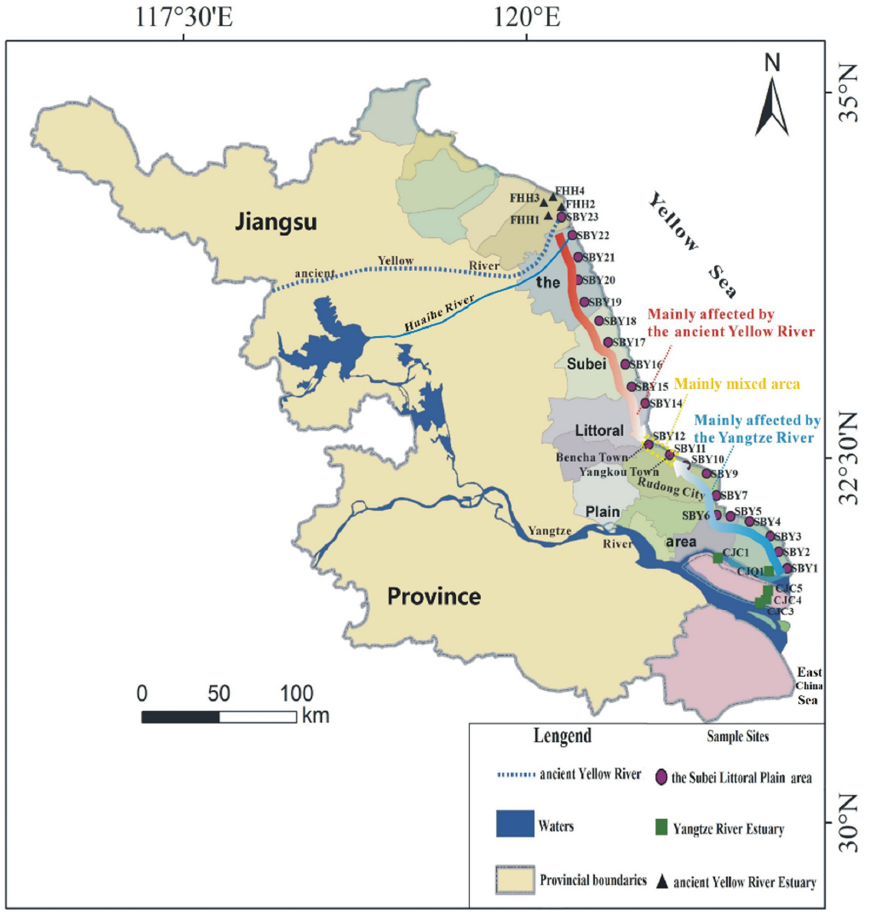
Figure 10. Ranges of the influence of the Yangtze River and the ancient Yellow River on detrital mica in the very fine sand sediments in the Subei littoral plain area.